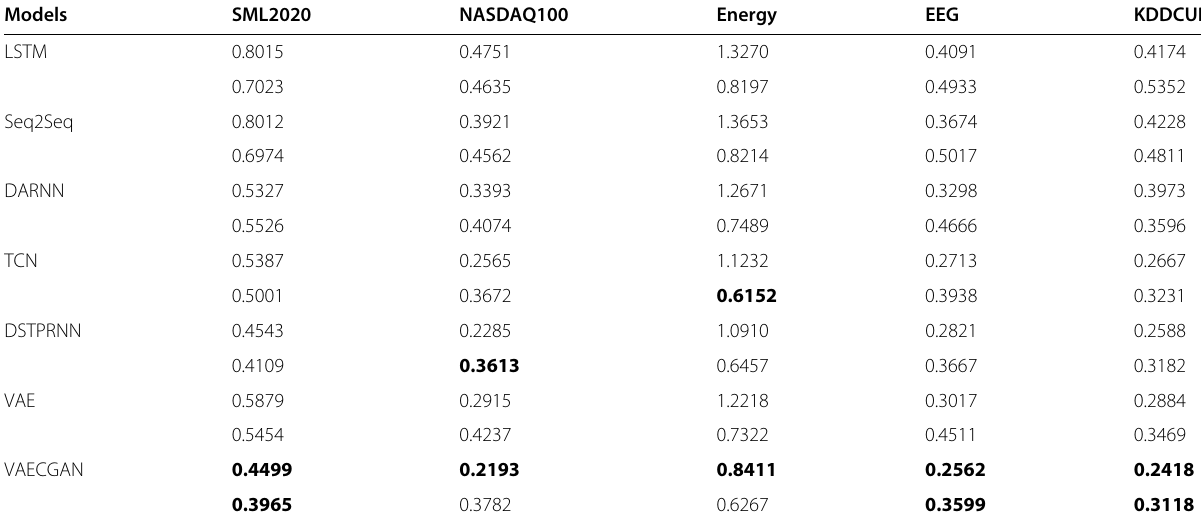
Table 2 The MAE and RMSE indexes of time series prediciton over the five datasets( (cid:2) =120)